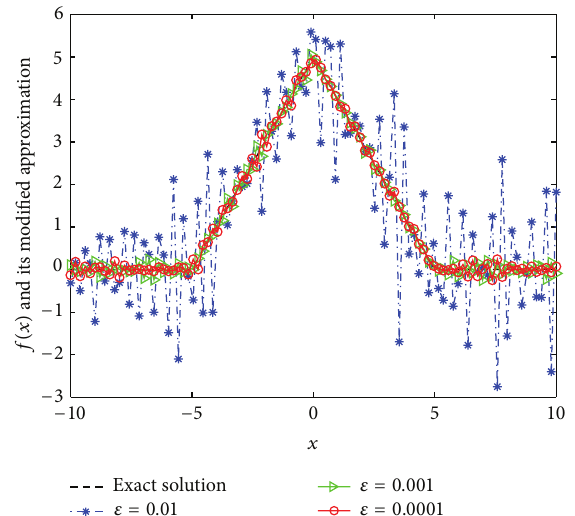
Figure 5: Comparison between the exact solution and its computed approximations with 𝑘 = 1 and various noise levels of 𝜀 = 0.1 , 𝜀 = 0.01 , 𝜀 = 0.001 for Example 6.